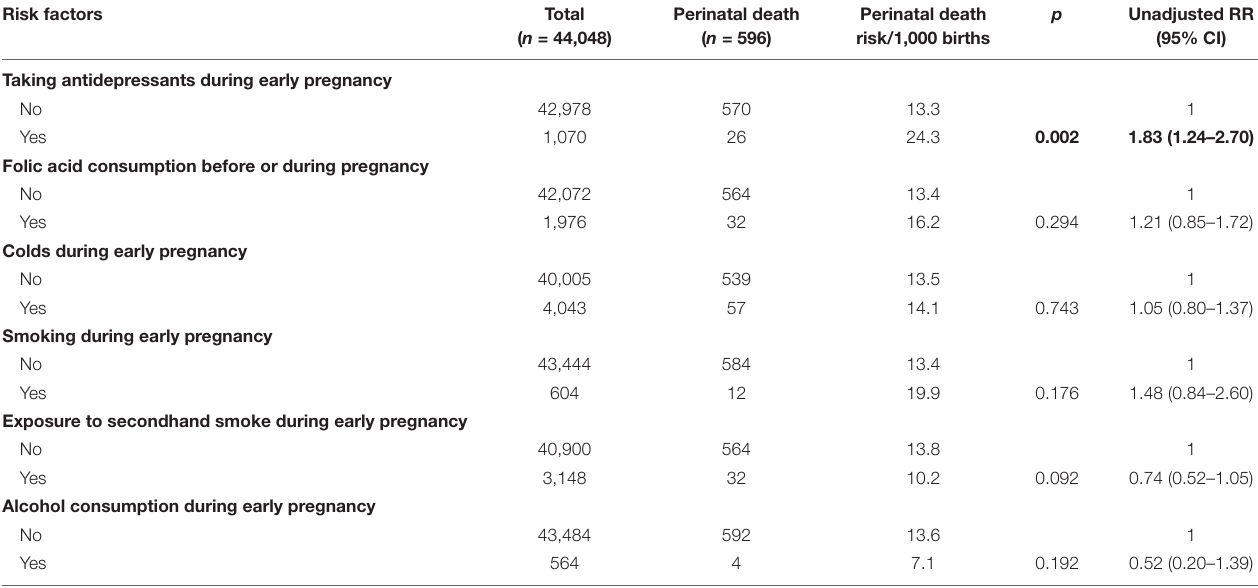
TABLE 3 | Lifestyle and habits during early pregnancy and unadjusted relative risk (RR) for perinatal death among 44,048 pregnant women. Risk factors